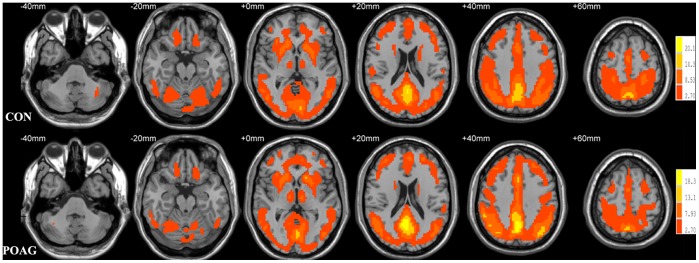
Results from one-sample t-test on ReHo maps for healthy subjects (CON, upper) and POAG patients (lower).Threshold was set to p<0.05 with AlphaSim correction.